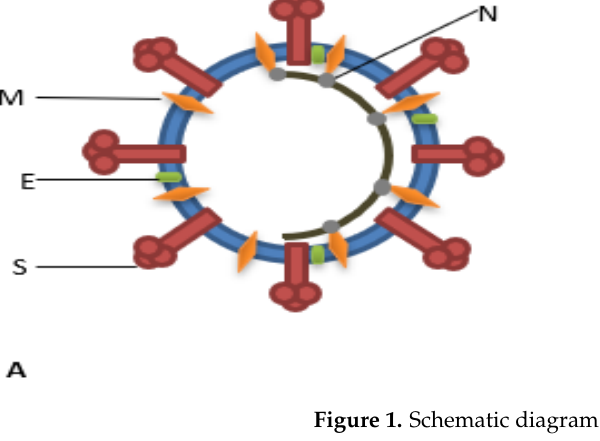
Figure 1. Schematic diagram of a coronavirus’ ( A ) virion and ( B ) genome.